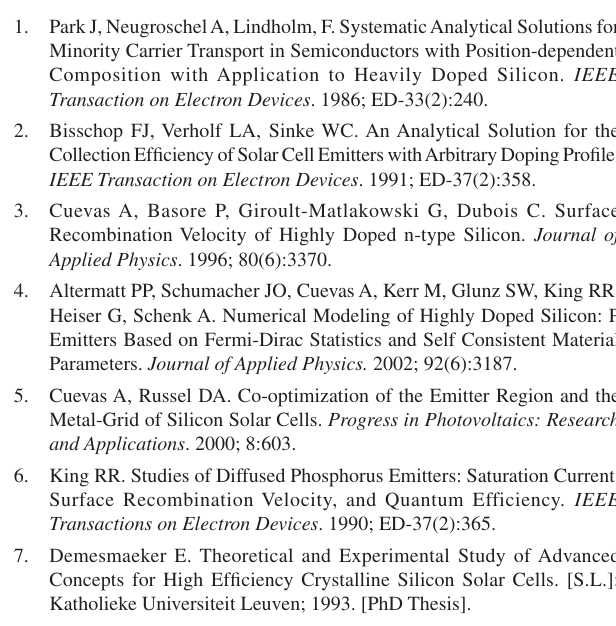
and thickness, W s e